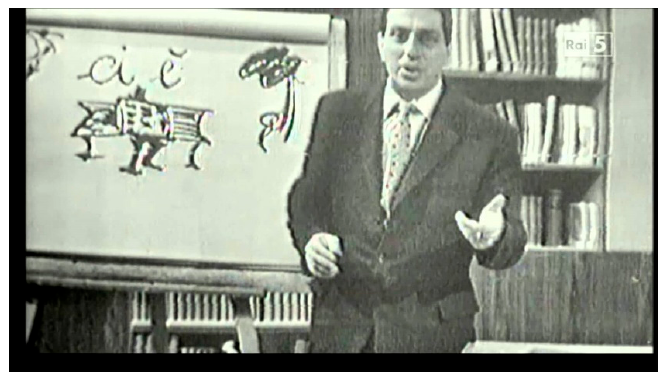
Figure 4. Alberto Manzi, Non è mai troppo tardi ,